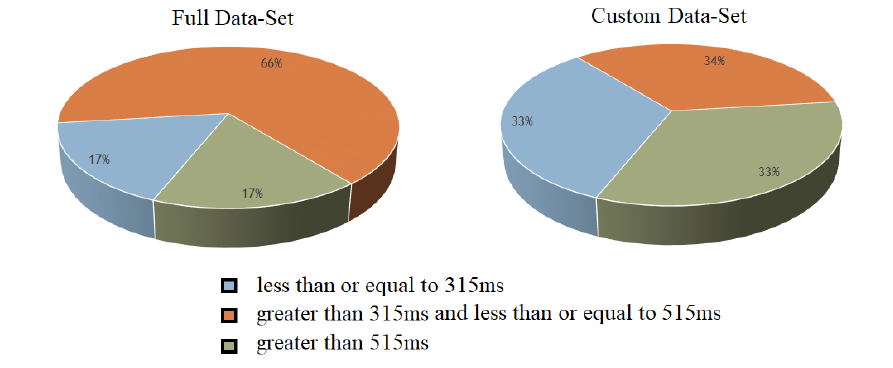
Figure 5. Custom dataset for 3-class classification.